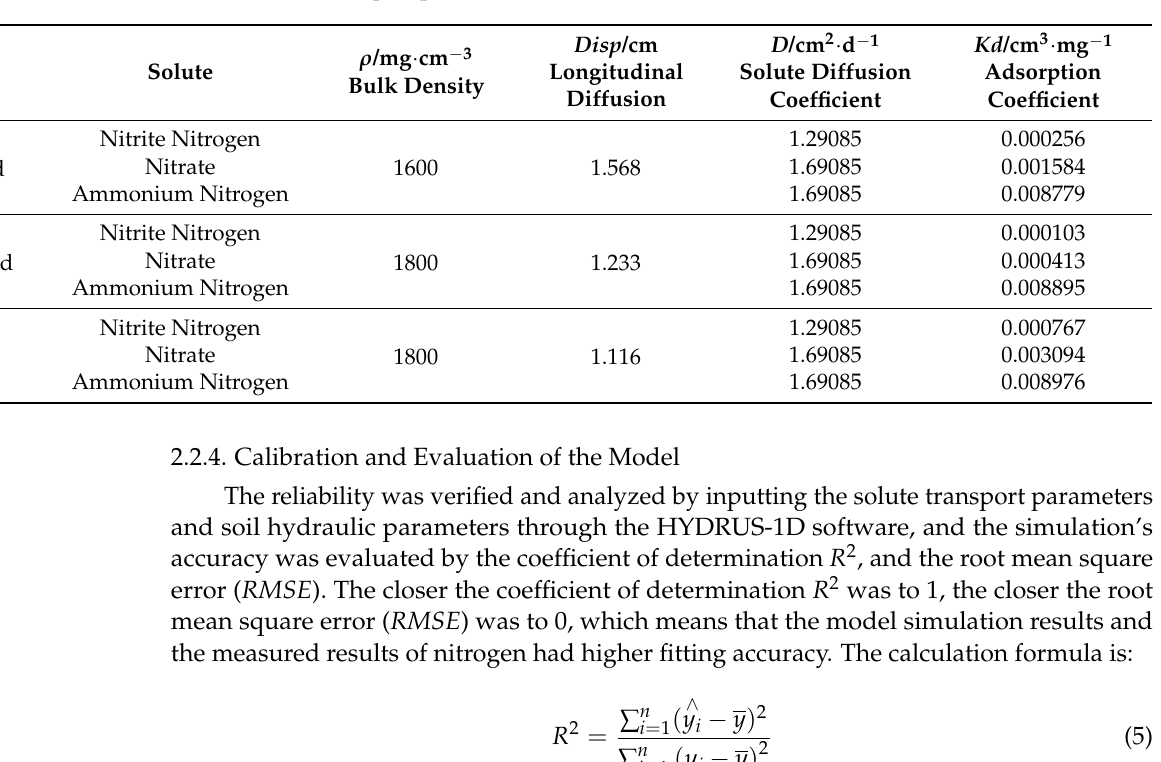
Table 4. Solute transport